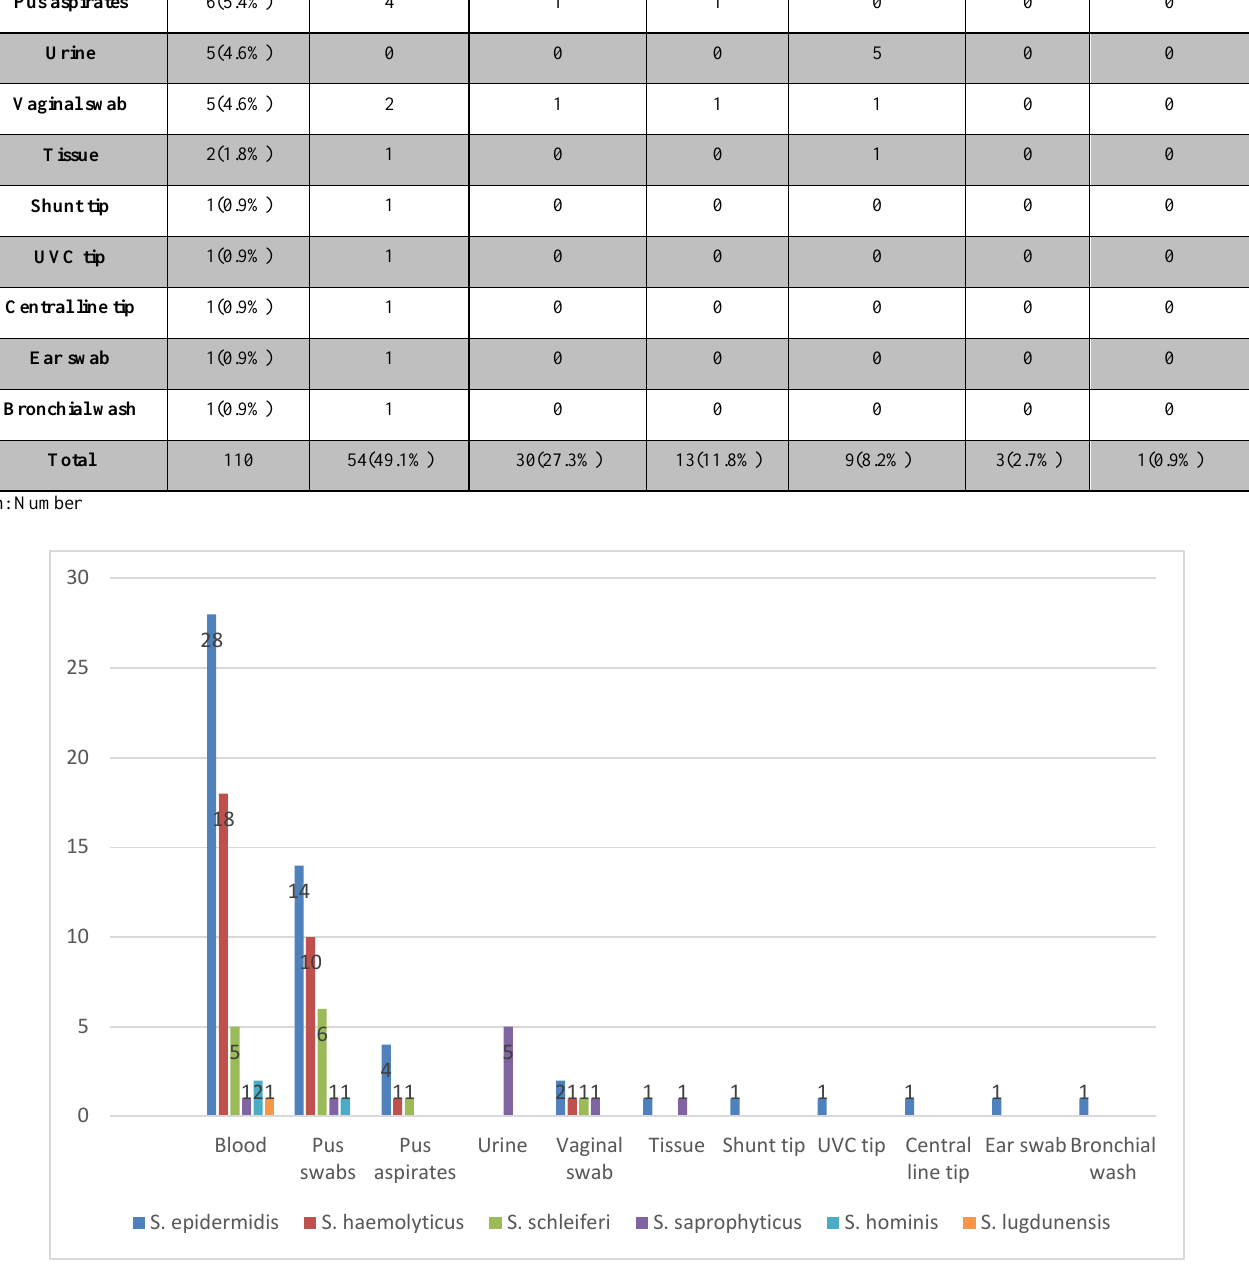
Fig. 2. Species distribution of CONS in various clinical